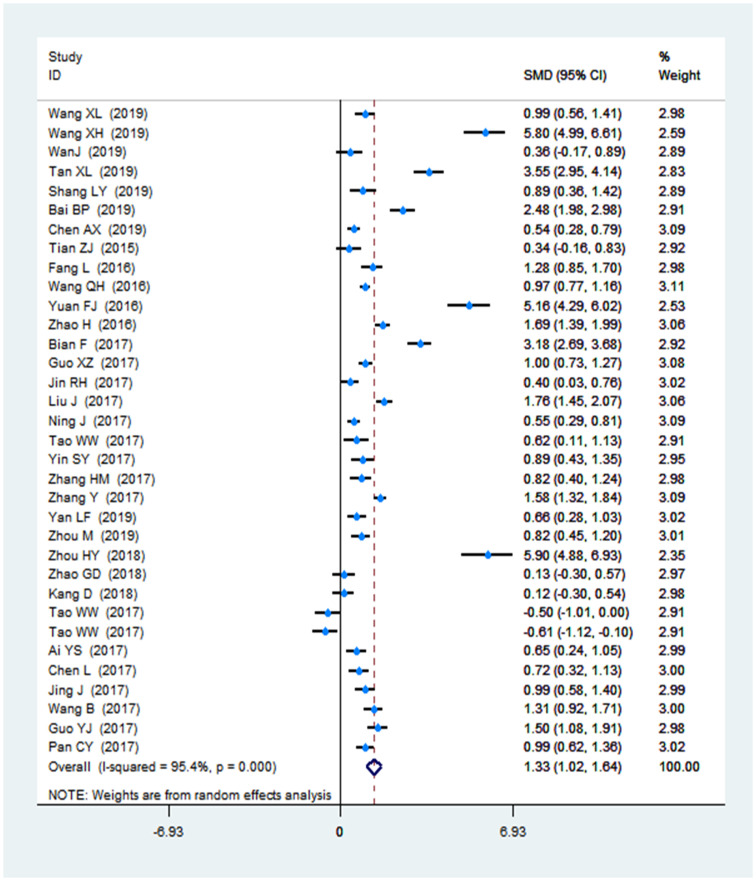
Forest plot of the nursing students' theoretical scores.